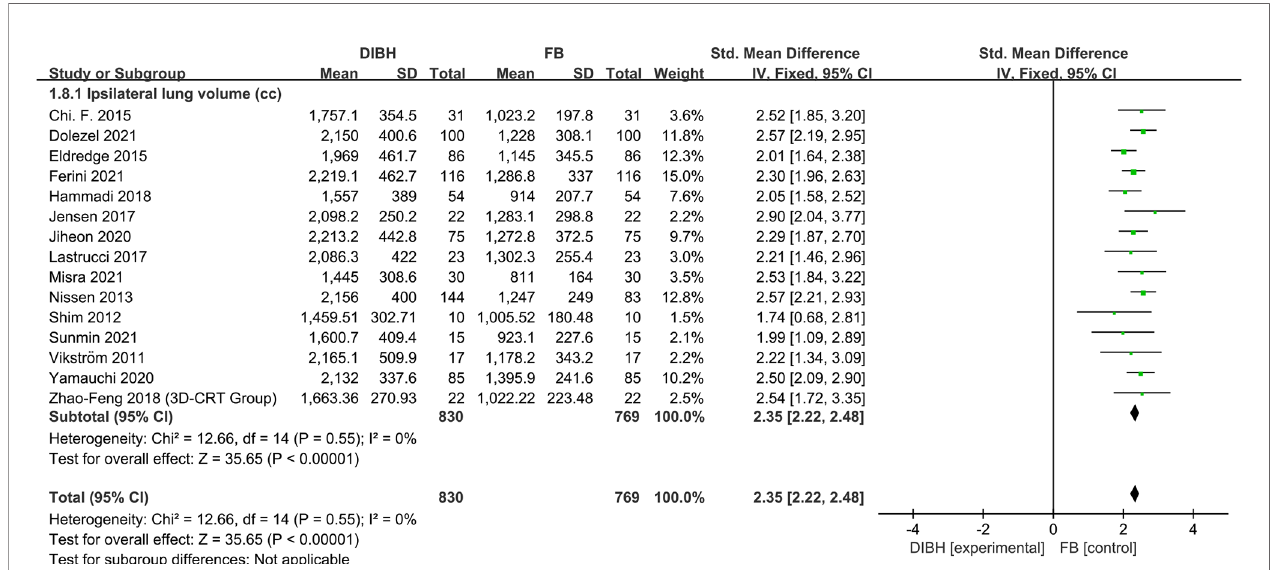
FIGURE 9 | Forest plot of ipsilateral lung volume between the DIBH group and FB